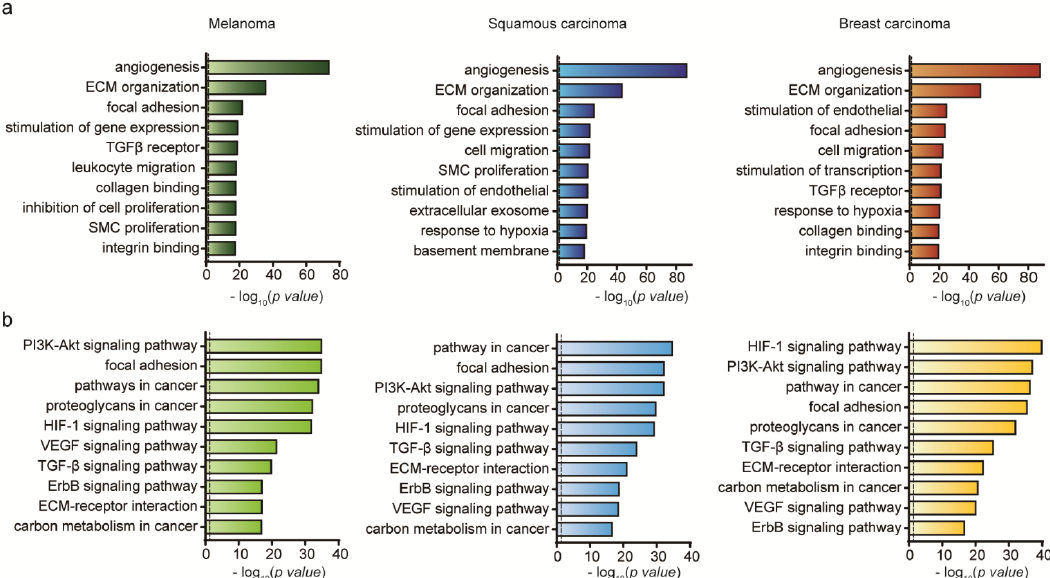
Figure 5. Comparative expression profiling of cancer invasion between ecCAFs and cCAFs. ( a ) Gene ontology (GO) term enrichment analysis of differentially expressed mRNAs in B16BL6, A431 and MDA-MB-231 cells ( p- value < 0.05, | log 2 (fold change) | > 1). ( b ) KEGG pathway analysis of differentially expressed mRNAs in B16BL6, A431 and MDA-MB-2321 cells ( p- value < 0.05, |log 2 (fold change)| > 1). The dashed line signifies a p- value of 0.05. The dashed line signifies a p -value of